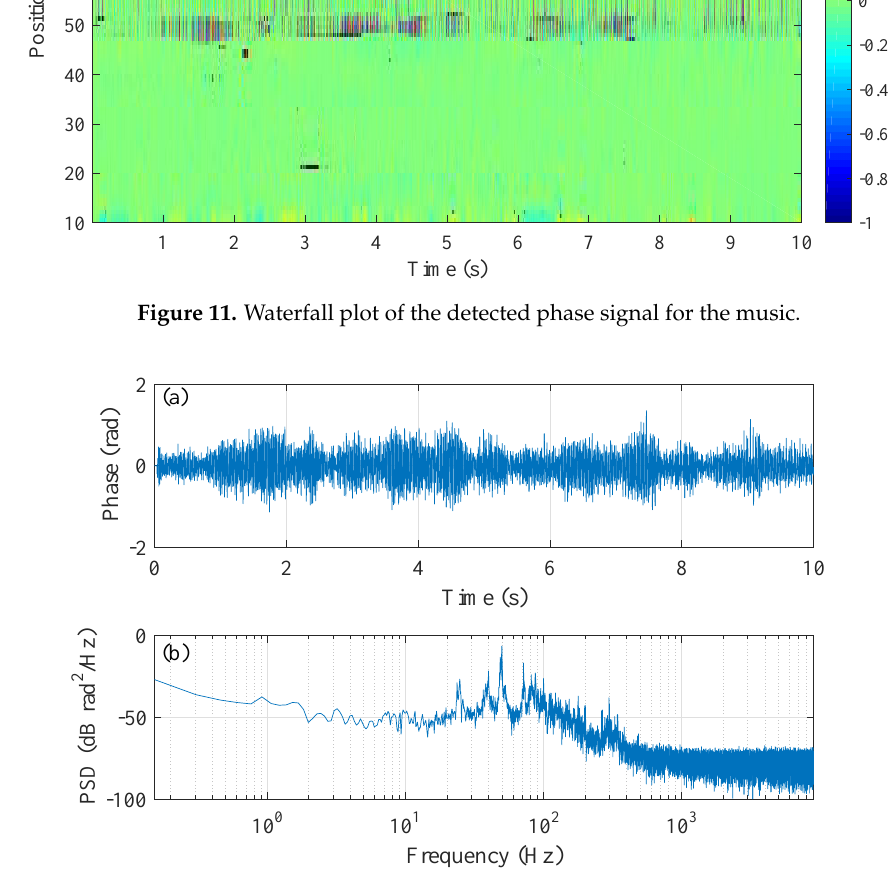
Figure 12. Plot of ( a ) the demodulated phase signal located at position 50 m and ( b ) its